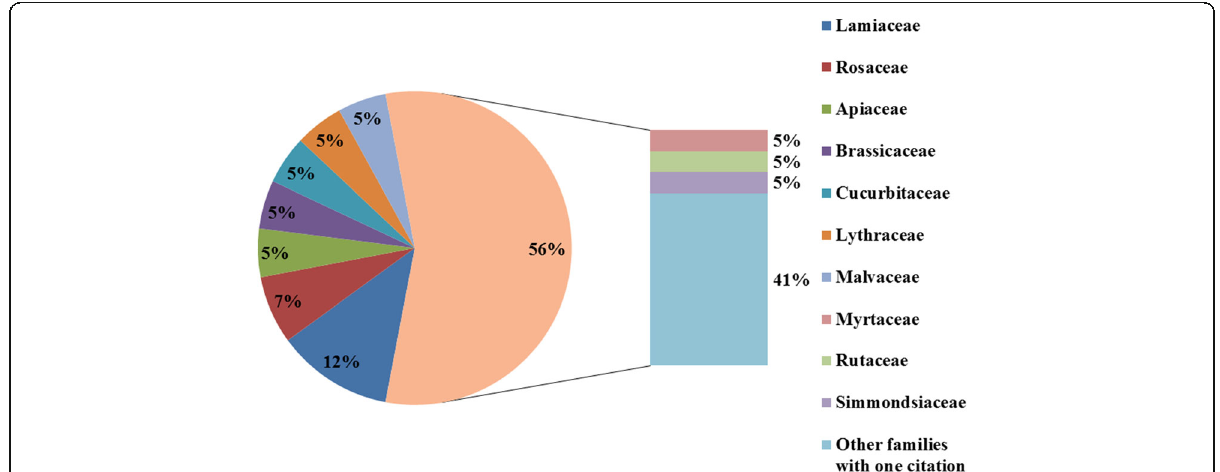
Fig. 2 Family use value for the used